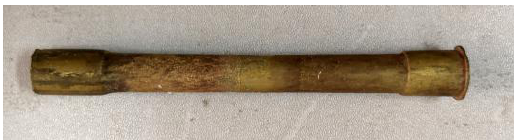
Figure 3. Copper tube after explosive consolidation.